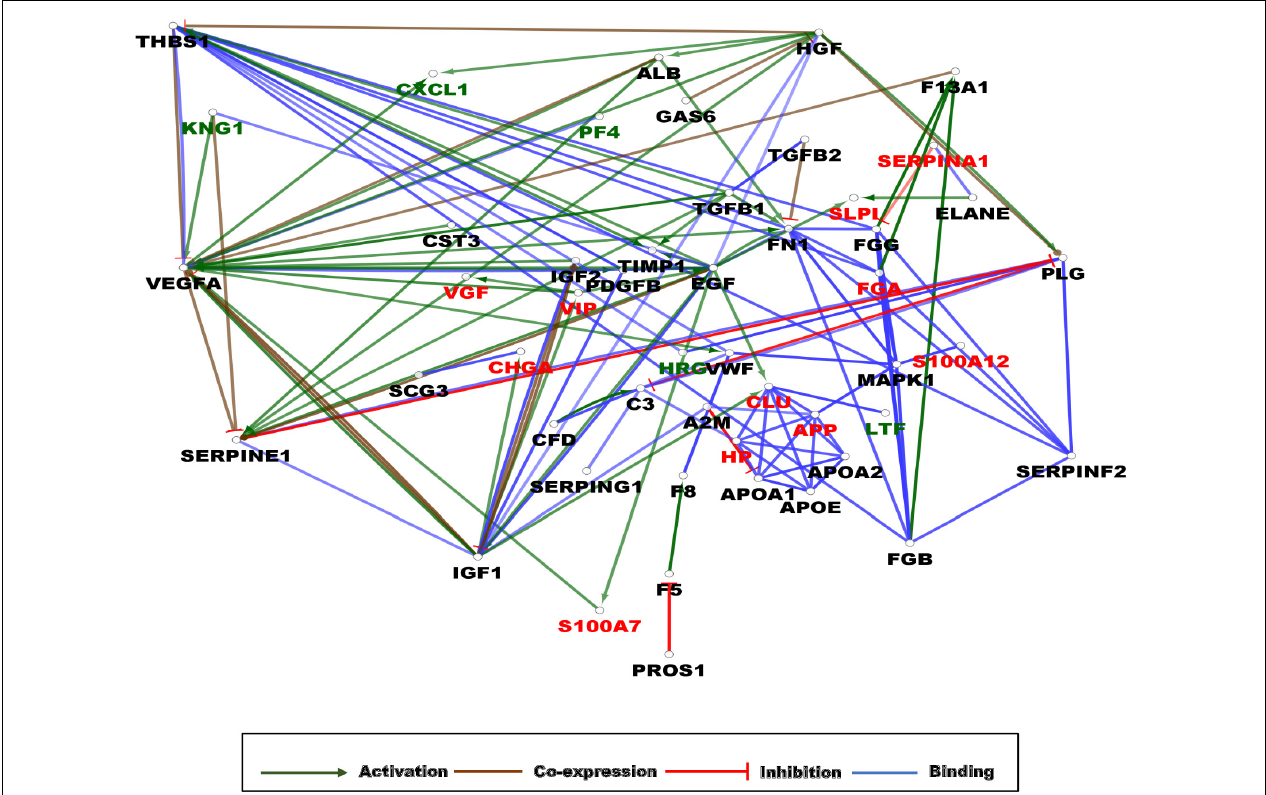
FIGURE 5 | Gene interaction network (GIN) of AMPs characteristic of AD. The circles represent a gene/protein and the lines indicate interactions. The lines with arrow represent activation, blocking lines represent inhibition, simple lines represent protein–protein interaction. Line color indicates the type of interaction: green color refers to activation, red color to inhibition, blue color binding, whereas brown color shows co-expression. The red color of protein label indicates AMPs whose amount changed in a statistically significant manner between AD and control samples, the black color shows their interacting partners with no AMP activity, while the green color indicates interactors with AMP activity. On all panels the proteins are labeled with their gene name. The higher resolution images of the individual networks are presented in Supplementary Figure 5